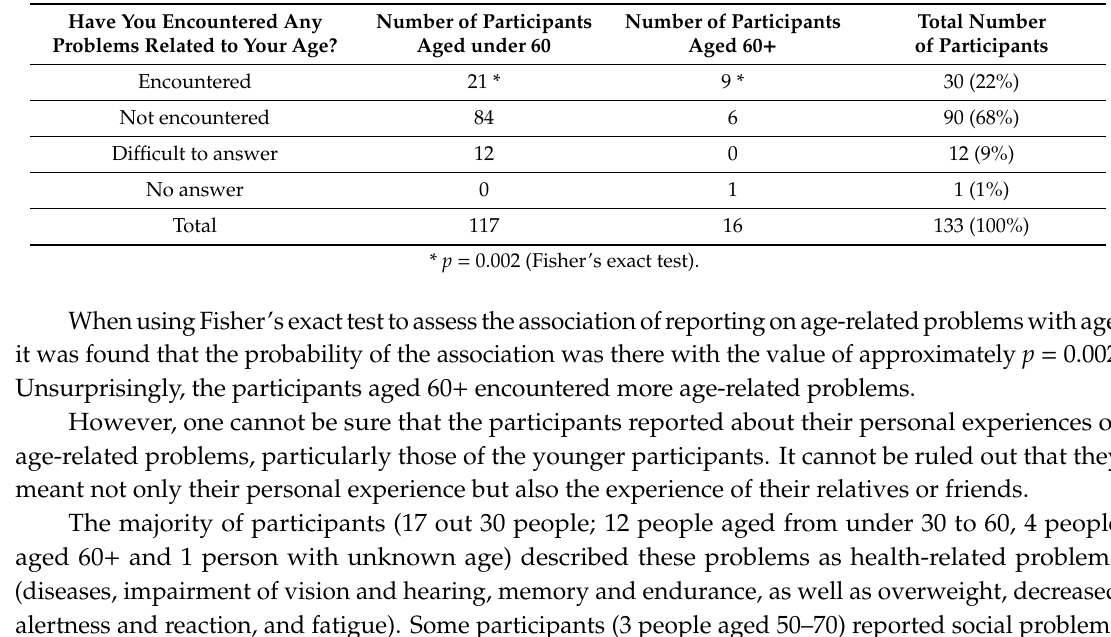
Table 7. Experience of age-related problems by age.